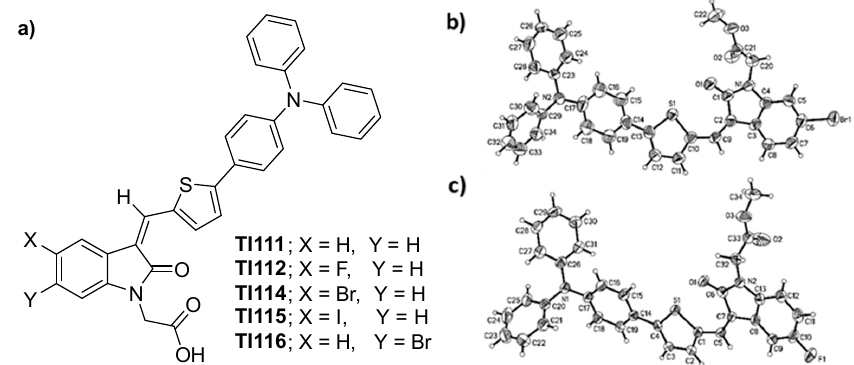
Figure 1. ( a ) Molecular structures of oxindole dyes ( TI111 − TI116 ). ( b ) ORTEP diagram of methyl ester of TI112 . ( c ) ORTEP diagram of methyl ester of TI116 .